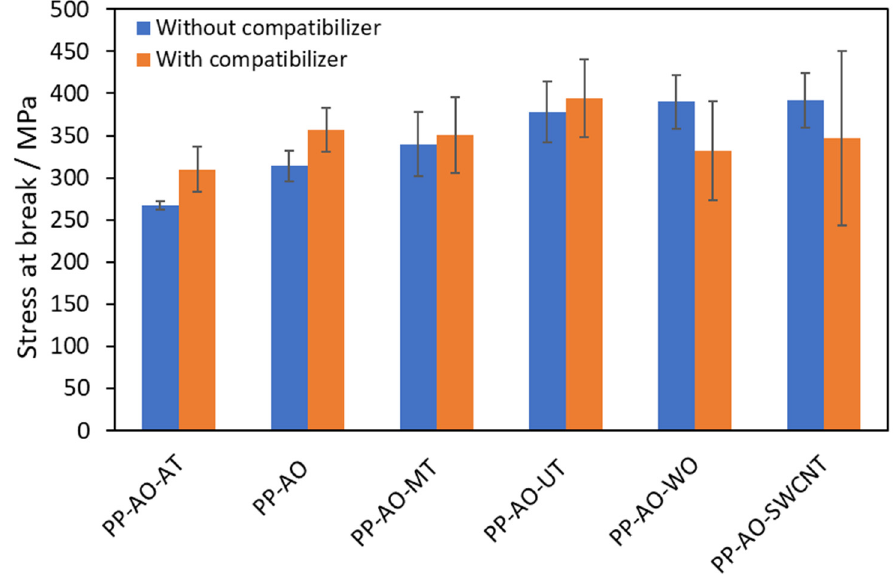
Figure 5. Tensile strength of the investigated drawn fibers.